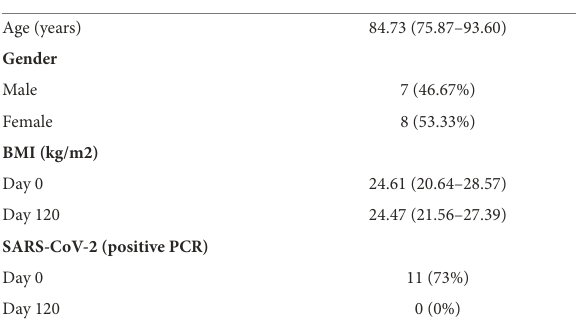
TABLE 1 Demographic characteristics of the elderly population ( n =